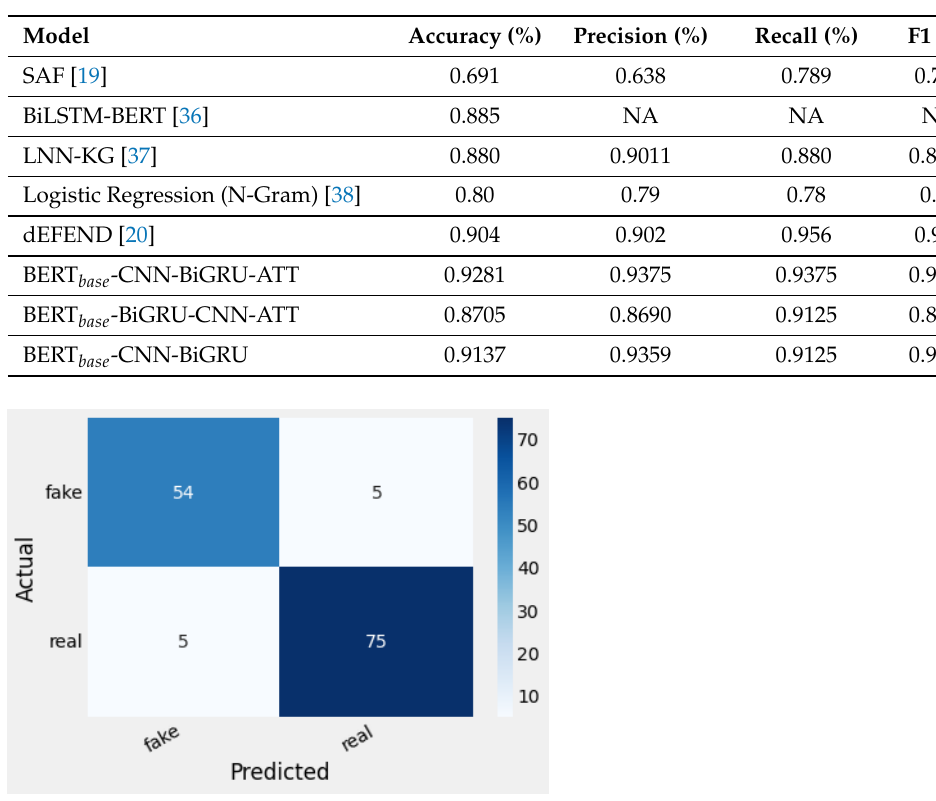
Figure 4. Confusion matrix of BERT base -CNN-BiGRU-ATT in PolitiFact.